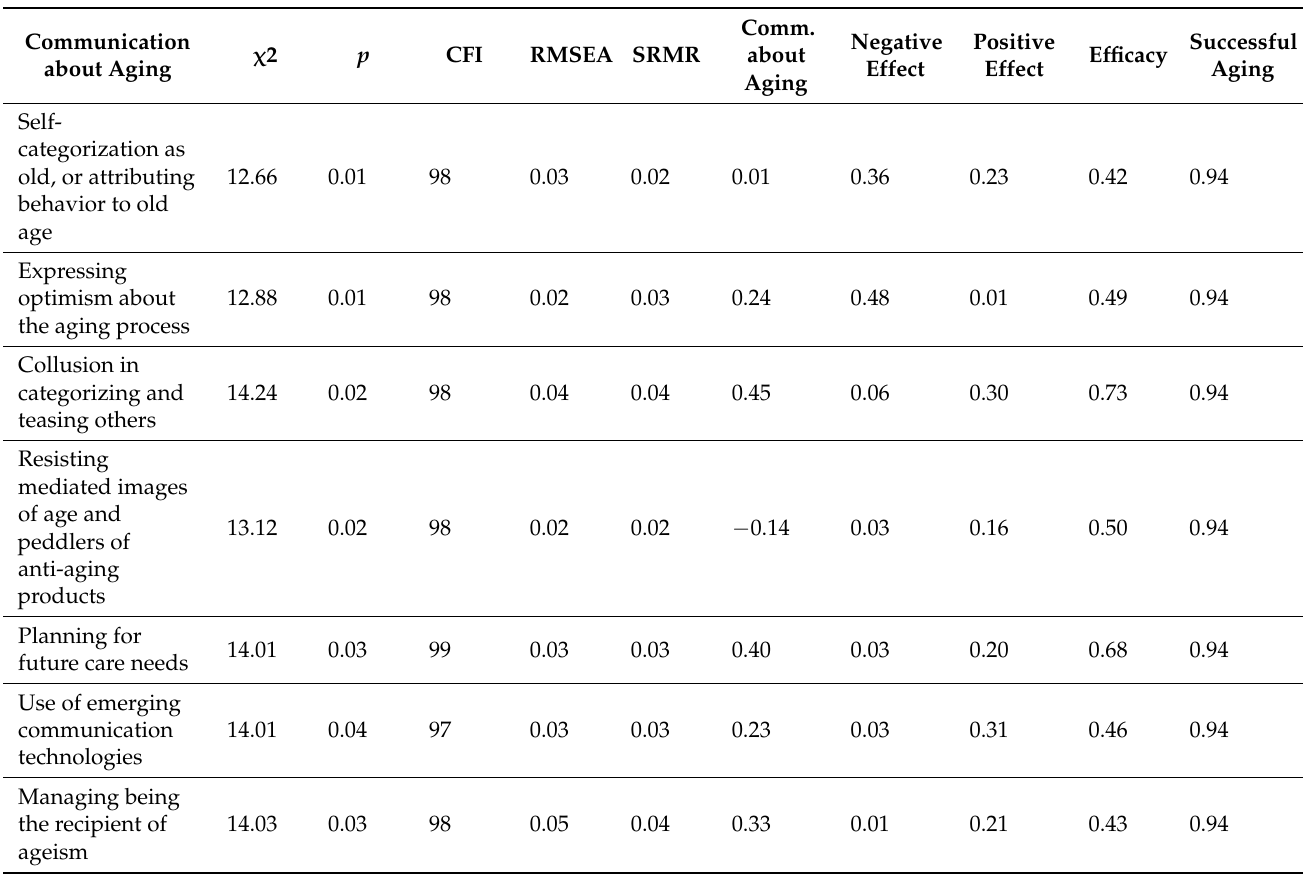
Table A4. Model fits